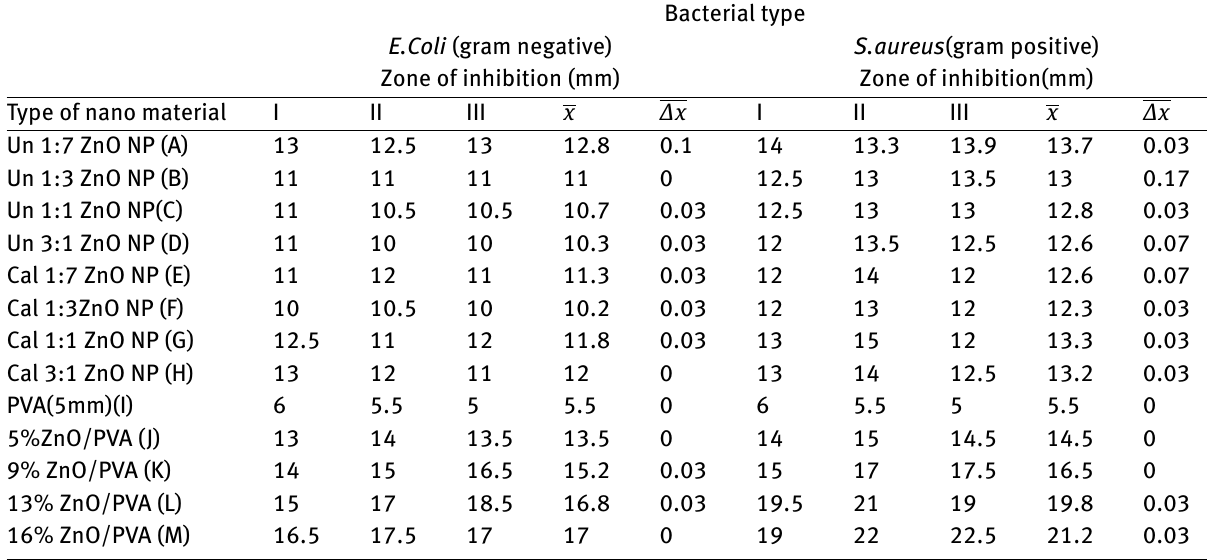
Table 5: Anti-bacterial inhibition zones of the synthesized nano materials: ZnO NPs (5 mg/ml), ZnO/PVA NCs (5 mm dispersed with 5 mg/ml